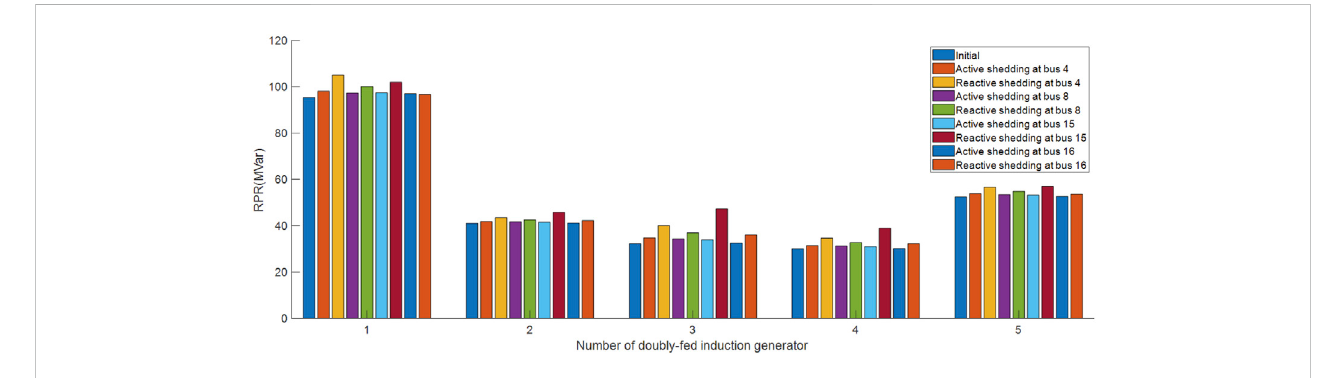
FIGURE 10 The effect of load shedding on RPR.